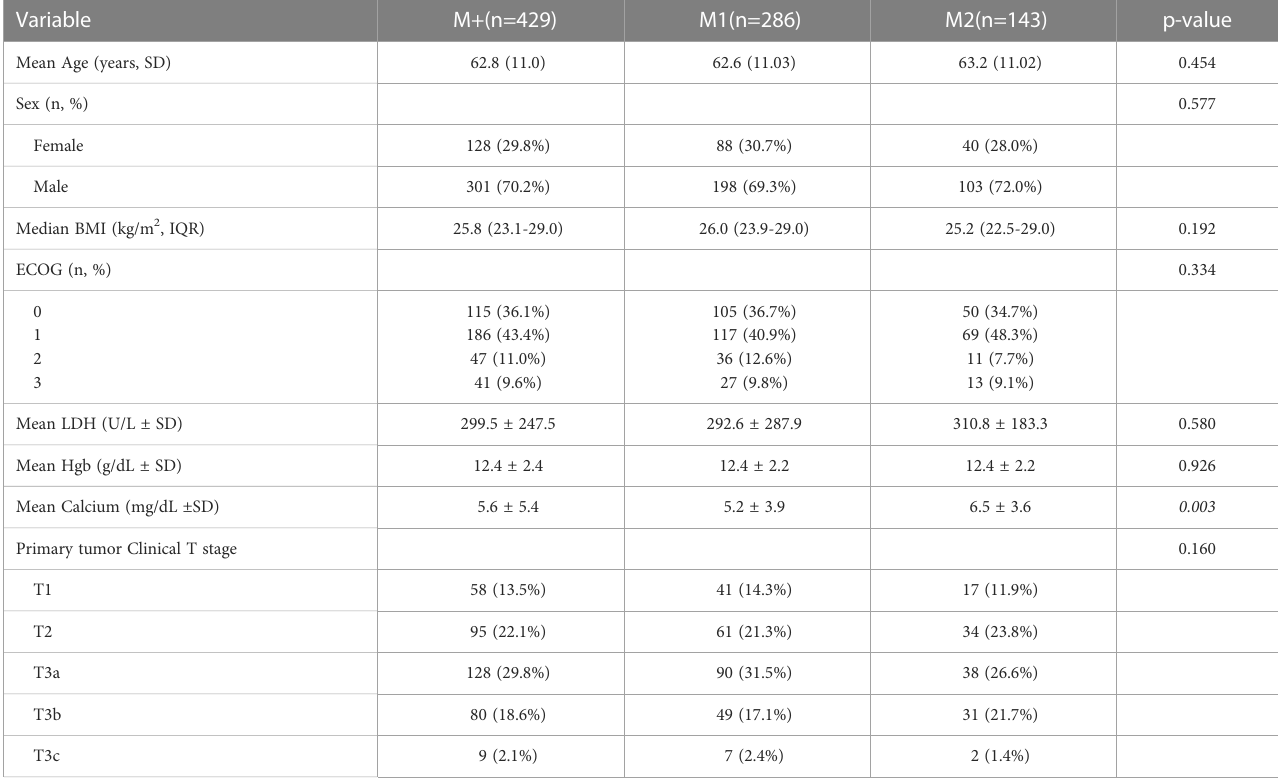
TABLE 1 Demographics, clinical disease characteristics and treatment